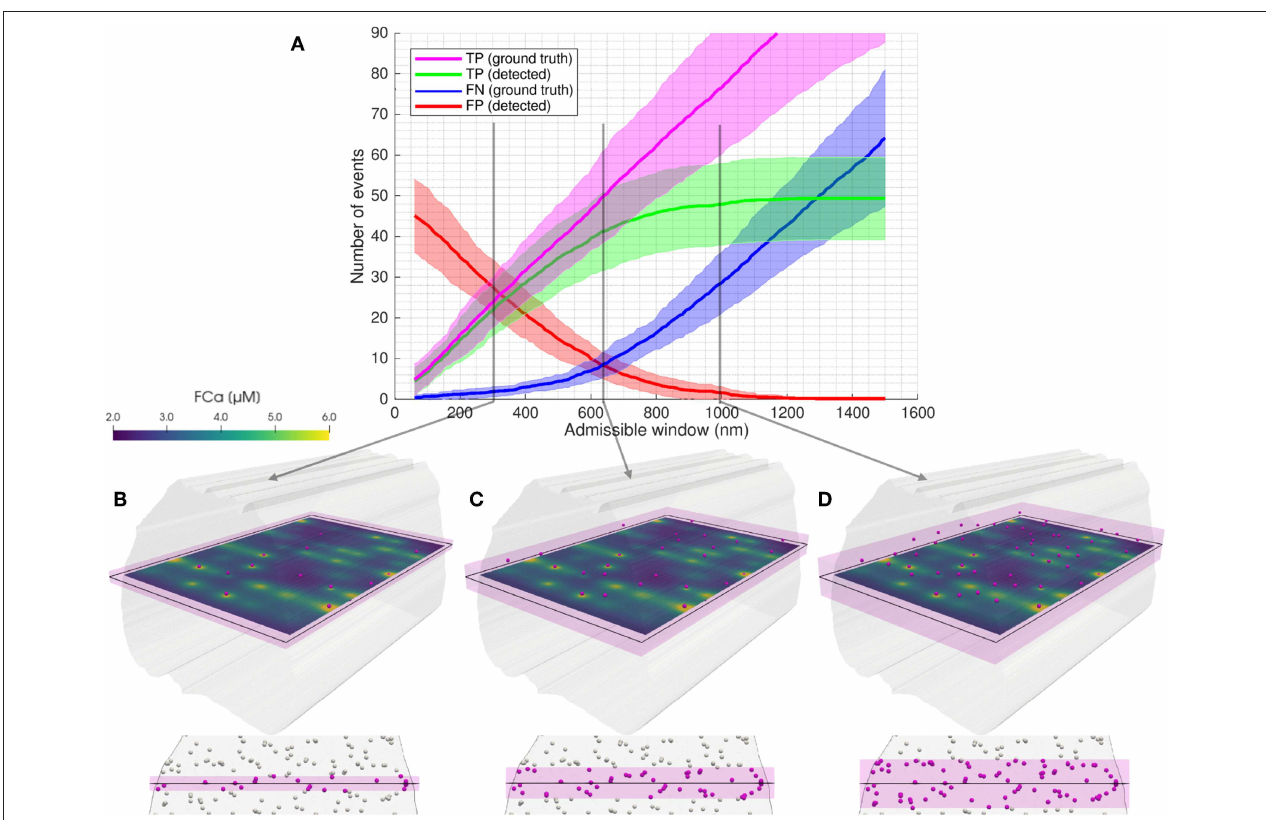
FIGURE 4 | Illustration of the admissible window parameter. The admissible window defines the distance tolerance from the simulated imaging plane for RyR cluster centers to be considered ground true positives. (A) Statistical classifier CaCLEAN results as a function of the admissible window for low cluster density, no mitochondrial barriers (case 3). Twenty two images were simulated with equidistant spacing through the model volume. Solid lines represent mean values and shaded regions indicate one standard deviation of values. Figure S1 shows similar results across the four model permutations. In (B–D) an example image slice is shown, with clusters considered TP (ground truth) for admissible windows of (B) 300 nm, (C) 640 nm, and (D) 1,000 nm in magenta. An oblique view is shown above, along with FCa model results at t = 15 ms. Below, an axial view perpendicular to the imaging plane is shown (looking through the modeled volume, with clusters outside the admissible window shown in white). The admissible window is indicated in pink